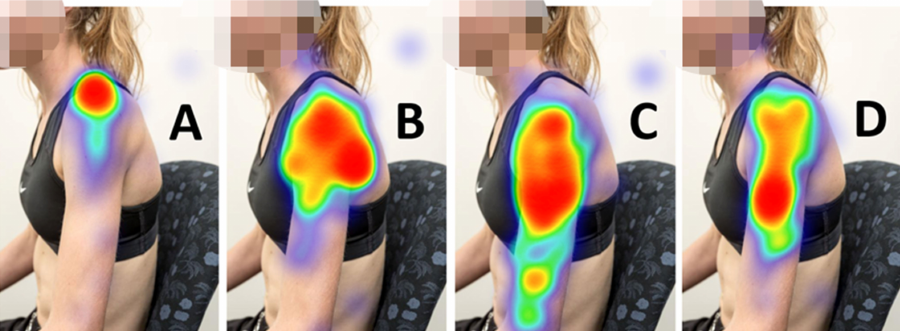
Figure 5. Heat map visualisation of selected location of anatomical structures. Key: ( A ) = Acromion